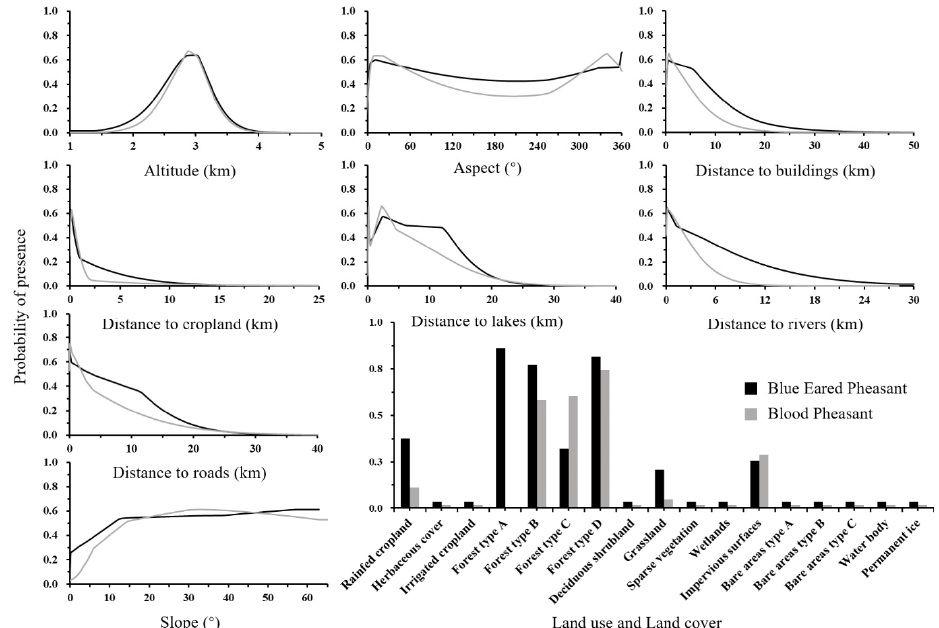
Figure 3. Probability of presence in reaction to different variables. Forest type A: closed evergreen broadleaved forest, forest type B: closed deciduous broadleaved forest, forest type C: open evergreen needle-leaved forest, forest type D: closed evergreen needle-leaved forest, bare areas type A: bare areas, bare areas type B: consolidated bare areas, bare areas type C: unconsolidated bare areas.